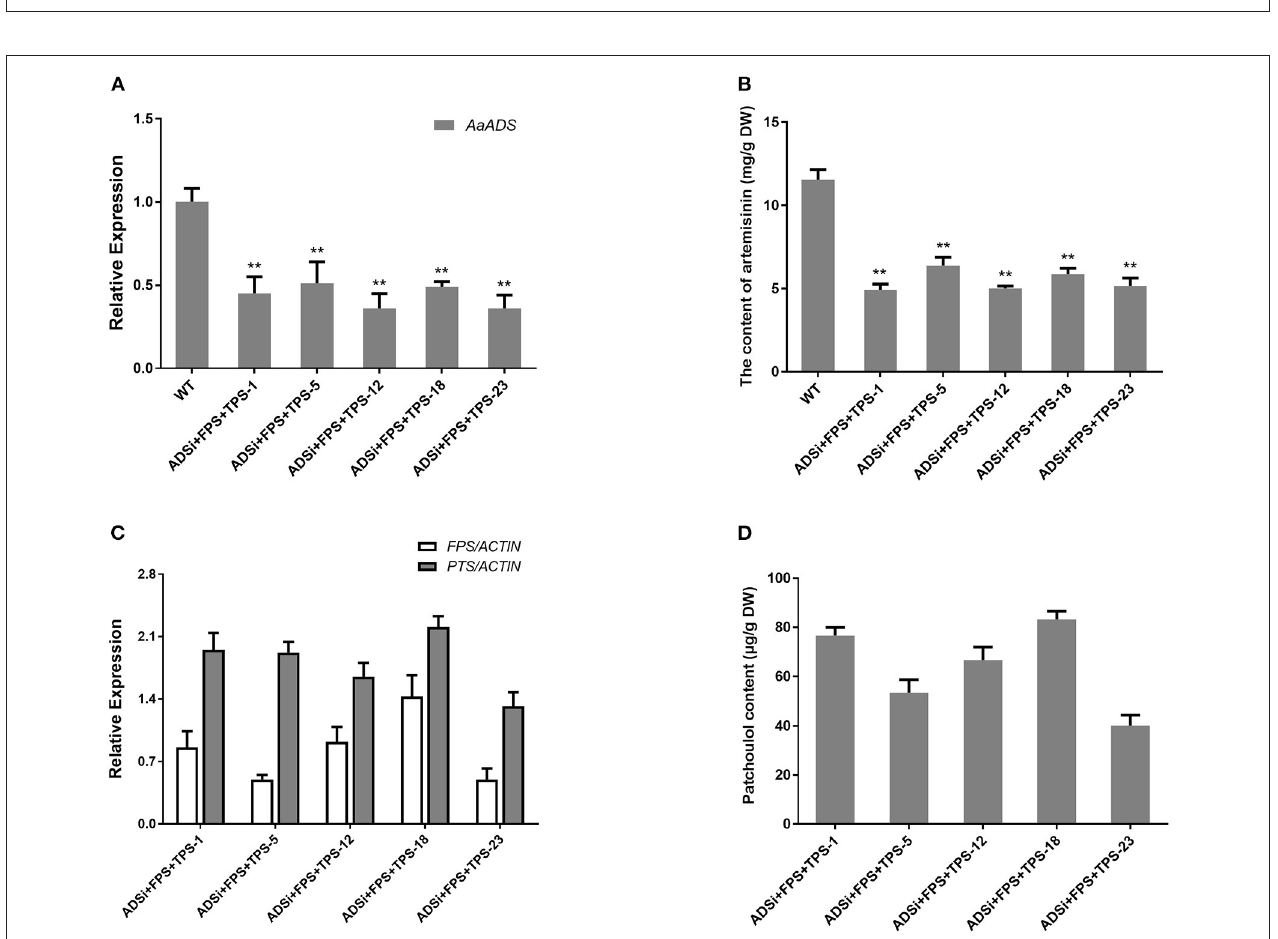
FIGURE 3 | Blocking the artemisinin biosynthesis increased patchoulol content in ADSi + FPS + PTS transgenic A. annua plants. (A) Relative expression of ADS in ADSi + FPS + PTS transgenic A. annua lines. (B) The artemisinin content in ADSi + FPS + PTS transgenic A. annua lines. (C) Relative expression of FPS and PTS in ADSi + FPS + PTS transgenic A. annua lines. (D) The patchoulol content in ADSi + FPS + PTS transgenic A. annua lines. T0 transgenic lines were used for analysis. ACTIN was used as internal control. The error bars represent the means ± SD from three biological replicates. All data represent the means ± SD of three replicates. ** P < 0.05, * P < 0.01, student’s t